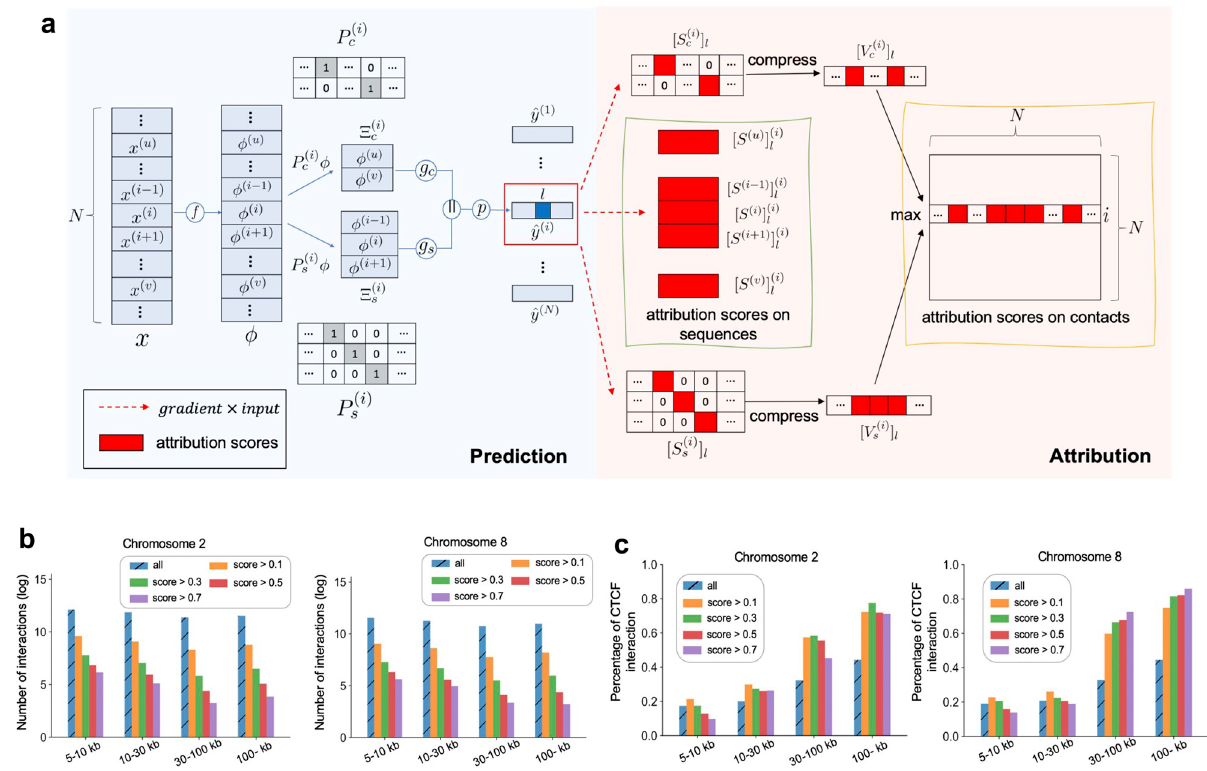
Fig 4. Details of attribution methods and validations of attributions on Micro-C contacts. (a) Workflow of attribution methods. If sequences u and v are the spatial neighbors of the central sequence i , sequences i − 1 and i + 1 are i ’s sequential neighbors, then in the forward propagation, sequence layers f are applied to extract hidden representation ϕ ( i ) for each sequence. Next, two binary sampling matrices, P ð i Þ to form two feature matrices, X ð i Þ and X ð i Þ . The two feature matrices are fed into graph layers ( g c s predicted chromatin feature vector ^ y ð i Þ . Next we take the gradient of the specific label l on i with respect to the inputs (two sampling matrices, the central sequence and neighbor sequences) independently, the attribution scores of each input which indicate the contributions to the central sequence i ’s label l , are calculated by gradient × input [21]. The attributions on the two sampling matrices, ½ S ð i Þ ½ V ð i Þ � and ½ V ð i Þ � , and then taken the maximum to become the i -th row in the interaction importance matrix. In addition, the attribution scores ½ S ð i (cid:0) 1 Þ � ð i Þ l l c s of the sequence i − 1 for label l on sequence i are computed. (b) Logarithm plots to show the total numbers of Micro-C contacts whose central sequence side bound by CTCF. Micro-C contacts are separated into four groups according to the contact distances: 5 − 10 kb, 10 − 30 kb, 30 − 100 kb, and 100 − kb. In each group, the contacts with CTCF related attribution scores greater than 0.1, 0.3, 0.5, and 0.7 are selected, and group ‘all’ is a baseline where contacts are not filtered by attribution scores. (c) Bar-plots to show the percentage of CTCF interactions, which is calculated as the number of contacts whose two sides were bound by CTCF over the total number of contacts whose central sequence was bound by